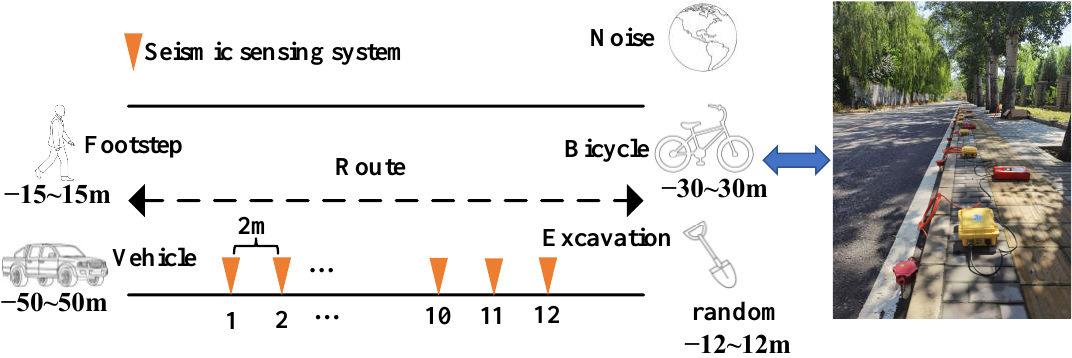
Figure 2. Experimental design and implementation of ground intrusion seismic signals acquisition using continuous seismic data acquisition sensing system.